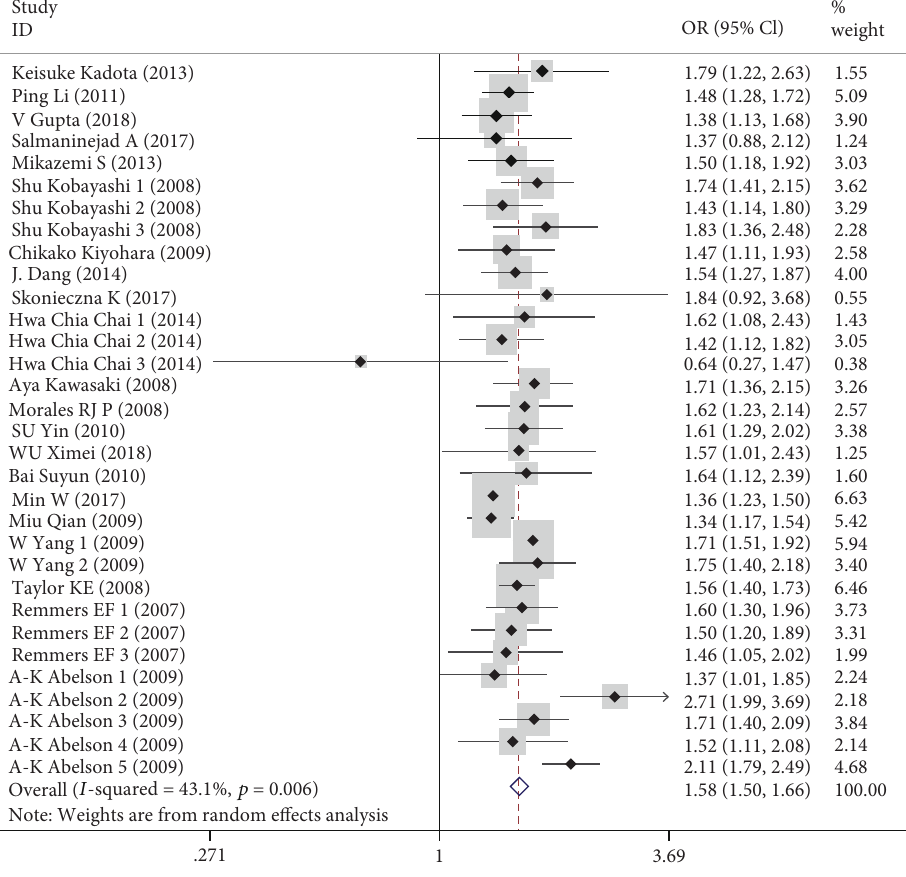
Figure 2: Forest plot for meta-analysis of STAT4 rs7574865 polymorphism and systemic lupus erythematosus (SLE) in all